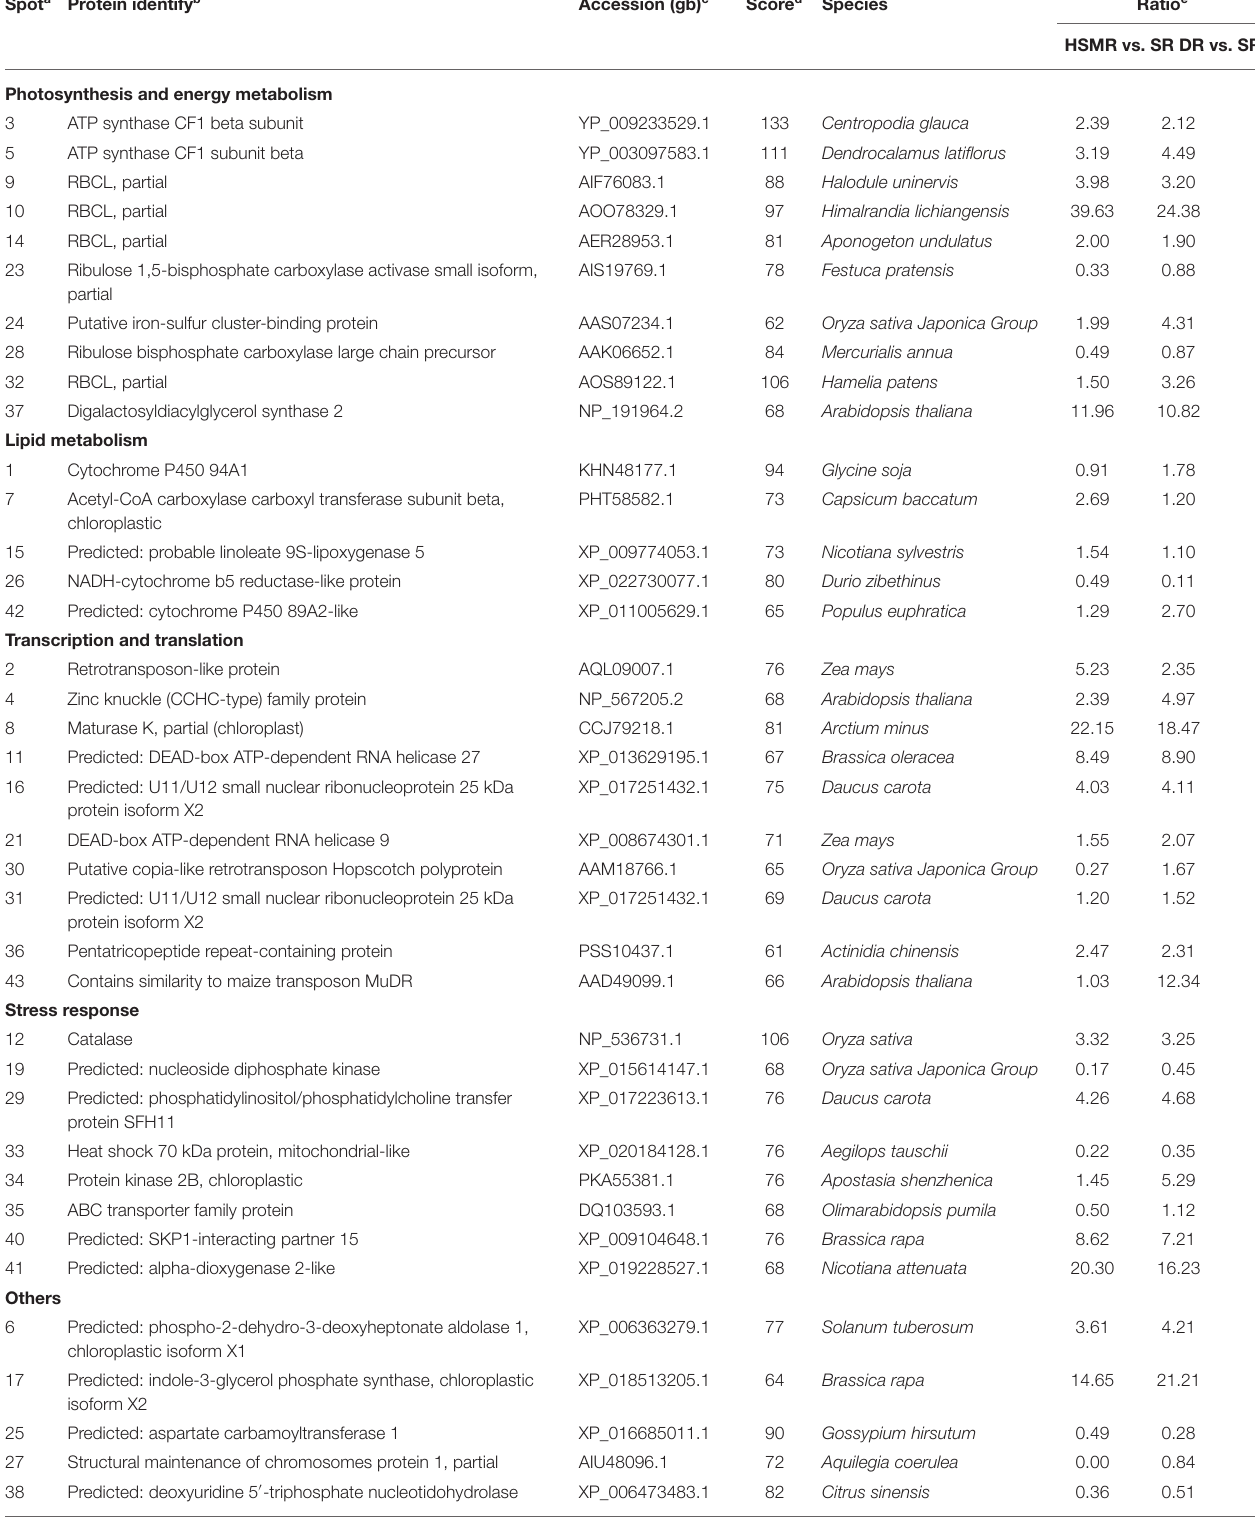
TABLE 2 | List of differentially accumulated proteins among the three reed ecotypes from various habitats. Spot a Protein identify